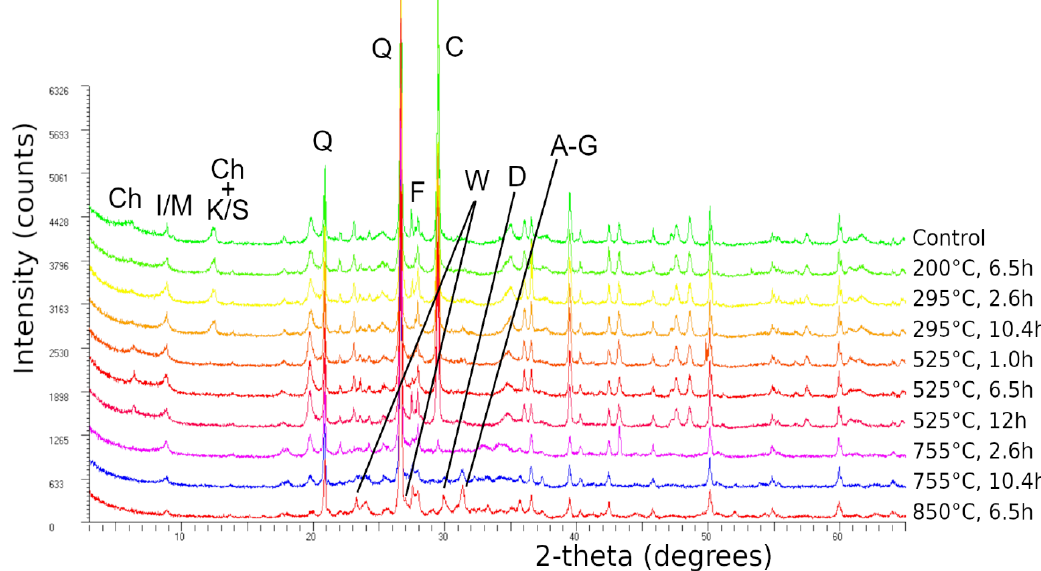
Figure 5. XRD profiles of the control and calcinated silt obtained with Cu Kα radiation. C = Calcite, Q = Quartz, W = Wollastonite, D = Diopside, A-G = Å kermanite–Gehlenite solid solution, I/M = Illite–Mica, Ch = Chlorite, K/S = Kaolinite/Serpentine, F = Feldspars.